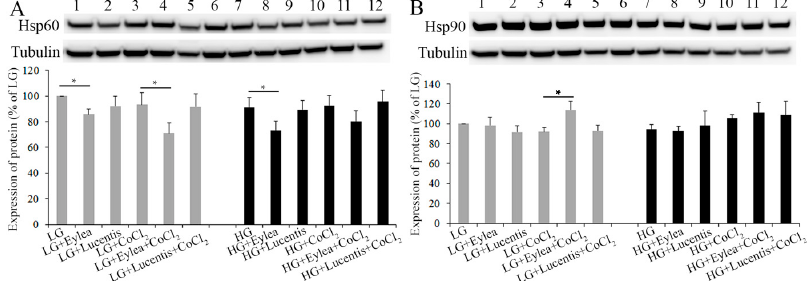
Figure 6. Effects of aflibercept and ranibizumab on Hsp60 and Hsp90 expression in Y79 photoreceptors. Y79 cells were incubated in stress media for 24 h. The effects of aflibercept and ranibizumab on Hsp60 ( A ); and Hsp90 ( B ) were studied by Western blots. * p < 0.05, n = 6/group.